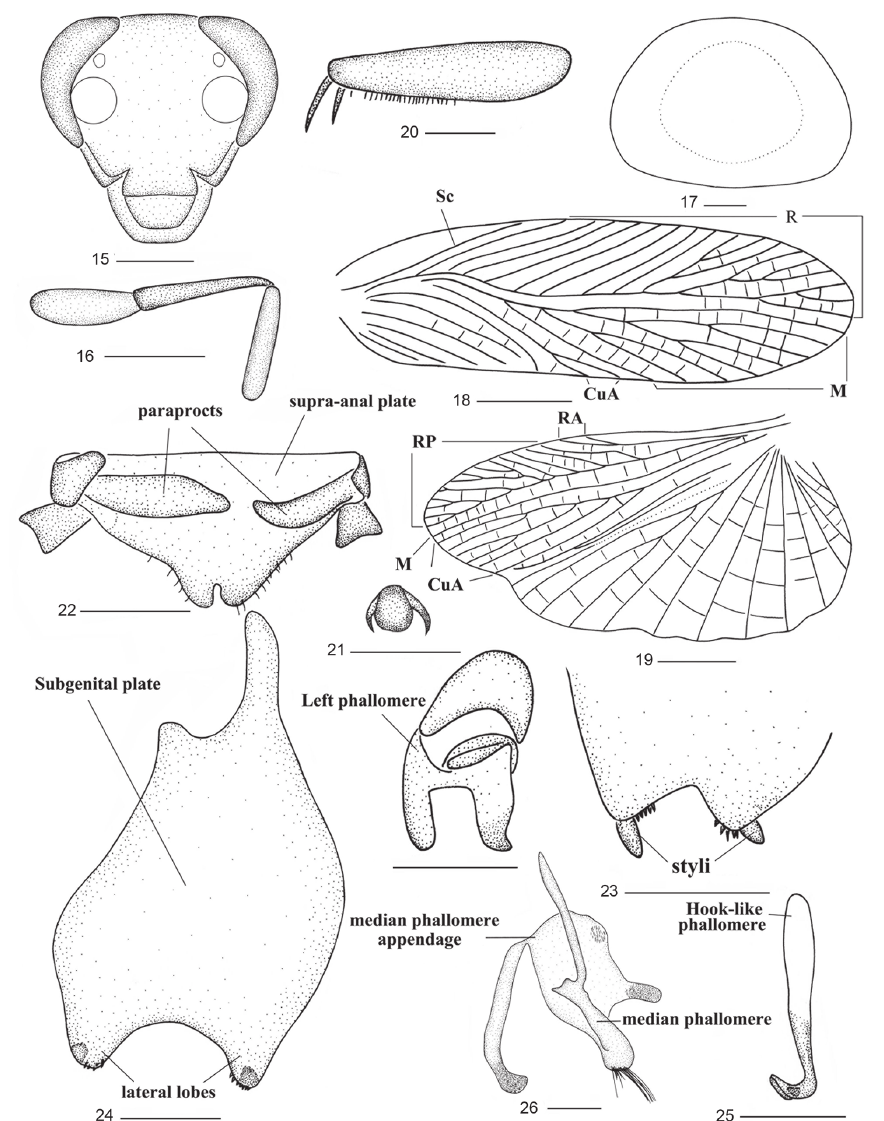
Figures 15–27. Balta crena sp. n. 15 head 16 maxillary palps 17 pronotum 18 tegmen 19 hind wing 20 front femur 21 tarsal claws and arolium 22 supra-anal plate and paraprocts, ventral view 23 subgenital plate, ventral view 24 subgenital plate, dorsal view 25 right phallomere 26 median phallomere 27 left phal- lomere. Scale bars: 0.5 mm ( 15–17, 20–27 ), 2.0 mm ( 18, 19